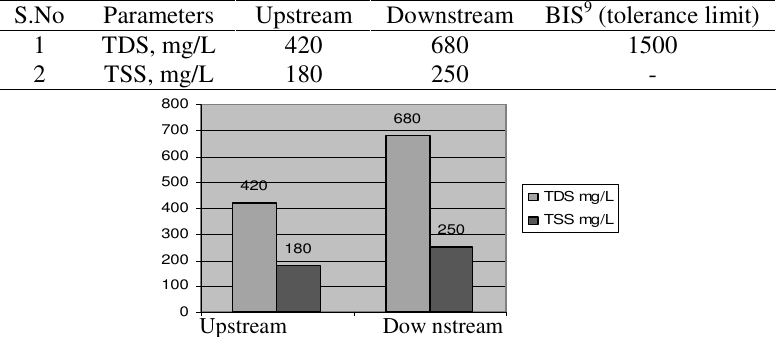
Figure 2. TDS and TSS of upstream and downstream